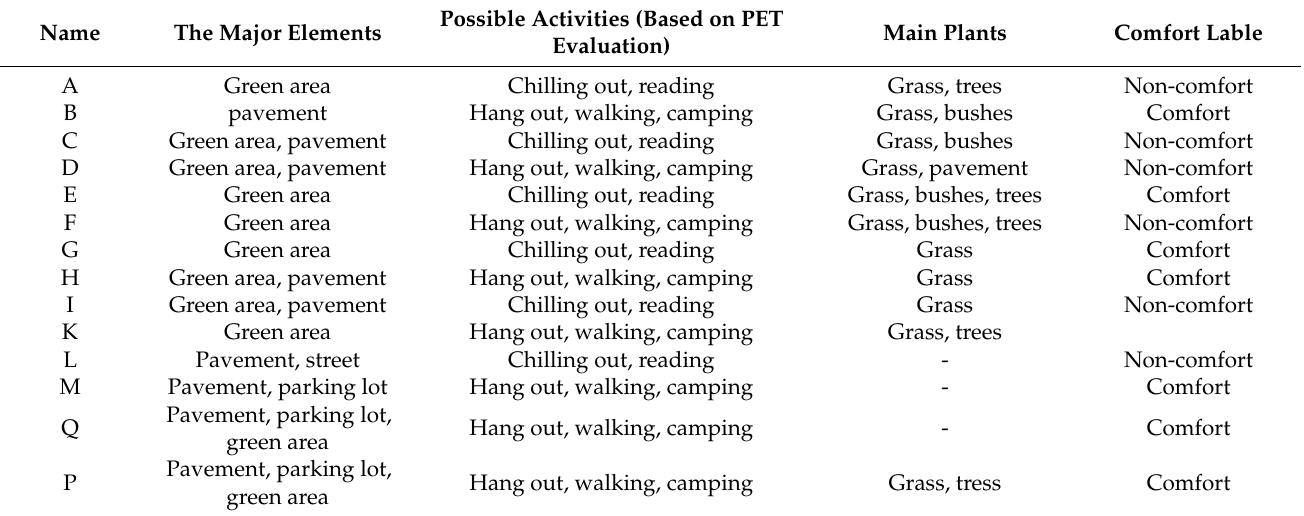
Table 9. Specification of different part of the campus and the comfort level based on PET